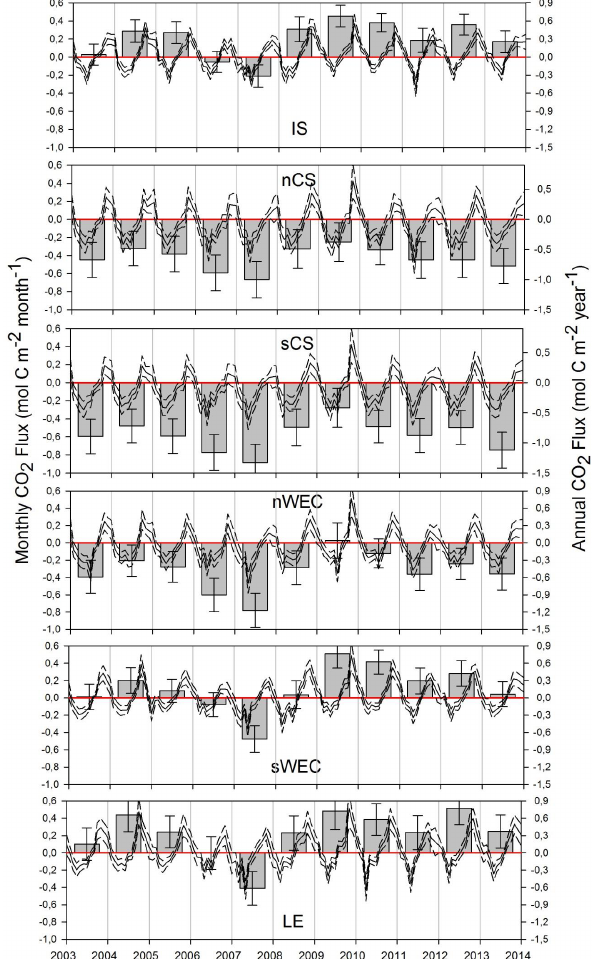
Figure 12. Monthly air–sea CO 2 fluxes (black lines, left-hand side y axis, molCm − 2 month − 1 ) computed from p CO 2,MLR and using Nightingale et al. (2000) K –wind relationship in IS (a) , nCS (b) , sCS (c) , nWEC (d) , sWEC (e) and LE (f) provinces from 2003 to 2013. Negative values indicate CO 2 sink. Integrated annual CO 2 fluxes (vertical grey bars, right-hand side y axis, molCm − 2 yr − 1 ) . The dashed line corresponds to the monthly fluxes plus and minus the calculated uncertainties, and the error bars correspond to the annual computed uncertainties (details in Sect.